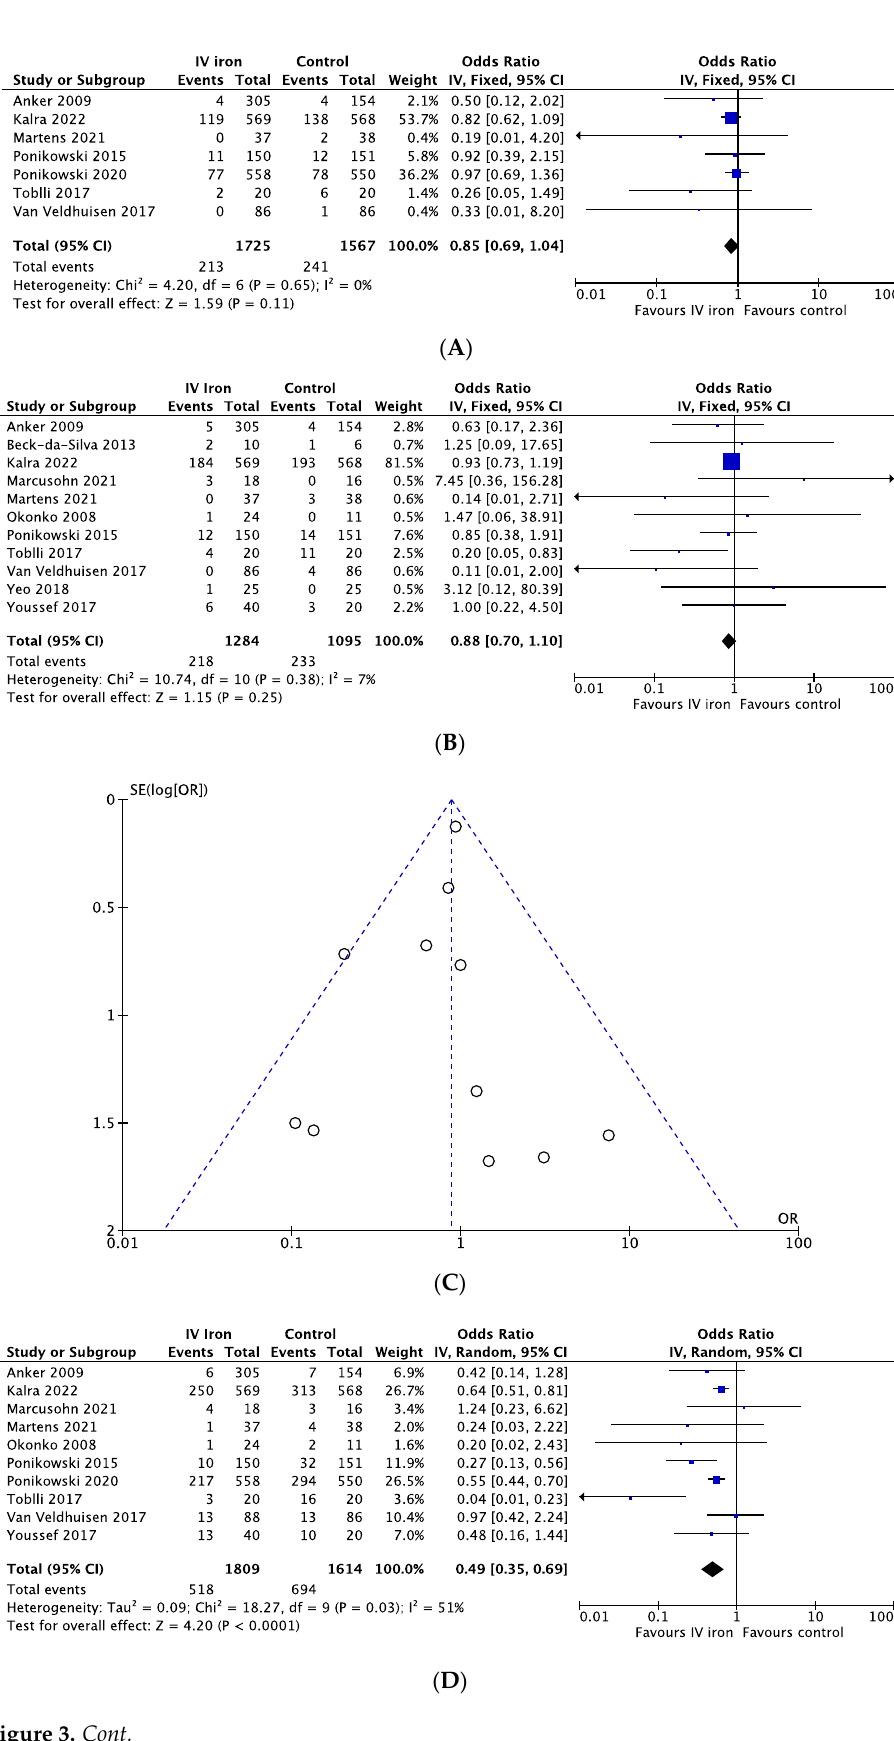
information provided in the full text articles [6–8,15,21,22,26]. Using a fixed effects model,